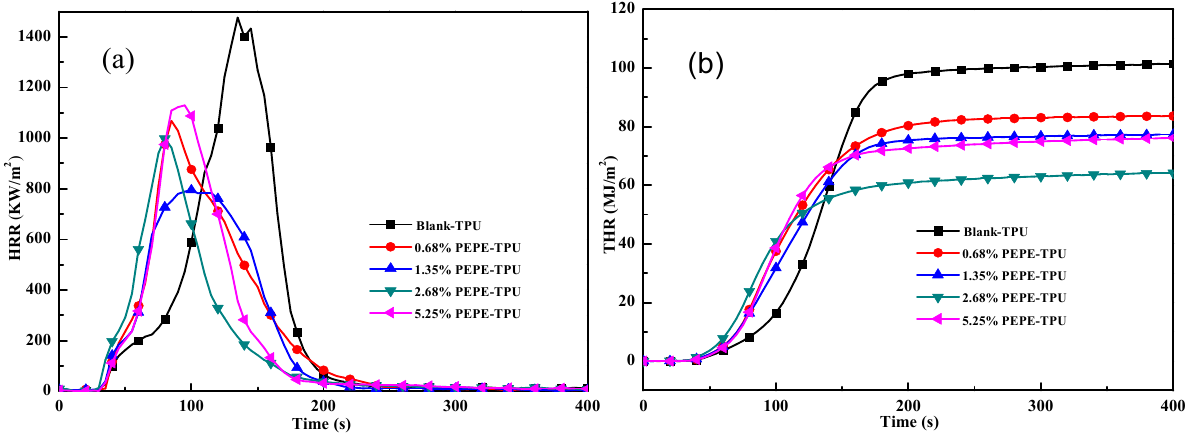
Figure 3. Combustion test curves of TPU with PEPE; ( a ) HRR and ( b ) THR. Table 4. Cone calorimetry data of flame-retardant TPU with